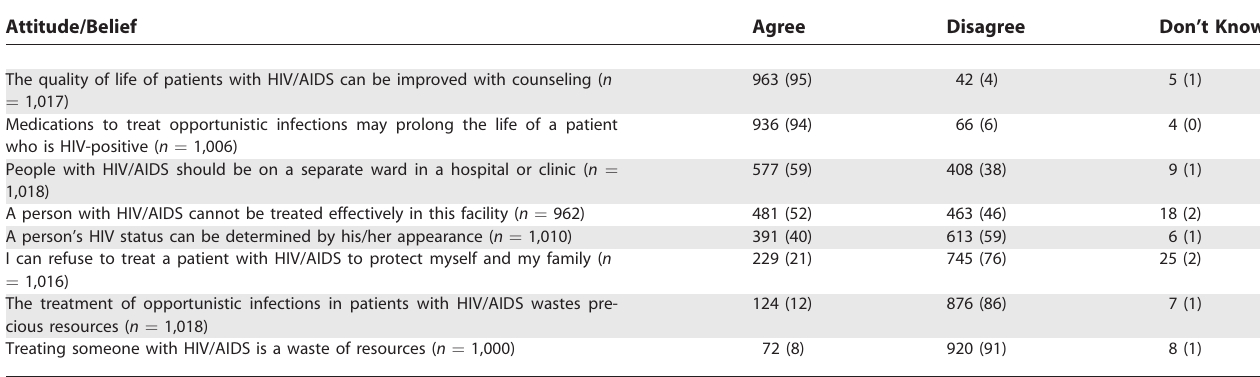
Table 7. Provider Attitudes and Beliefs regarding Treatment and Care of Patients with HIV/AIDS Attitude/Belief Agree Disagree Don’t